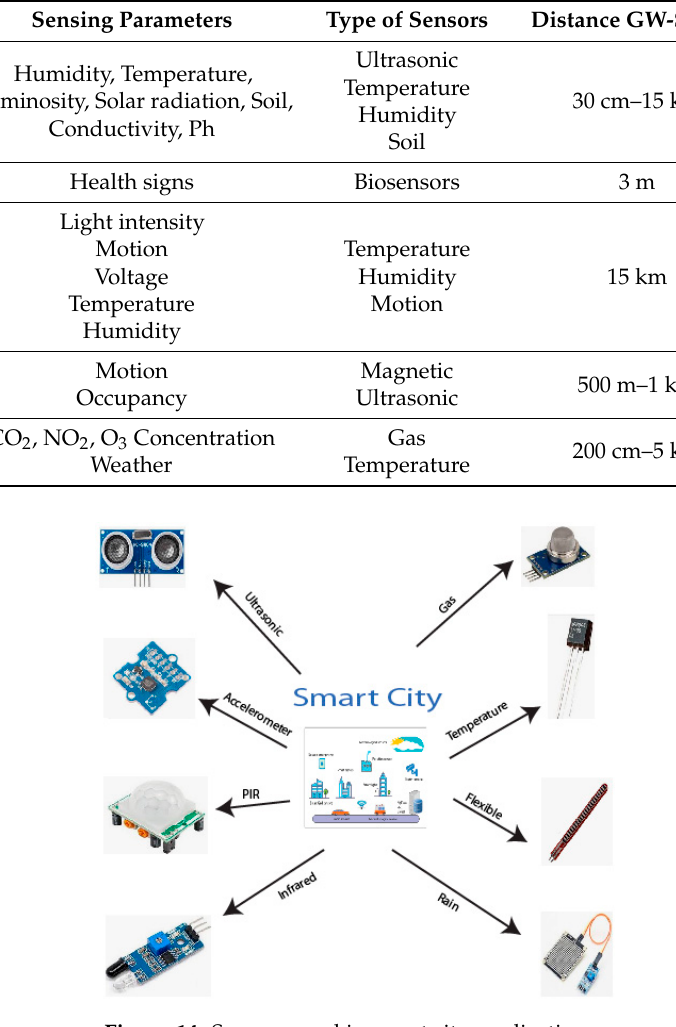
Figure 14. Sensors used in smart city applications.